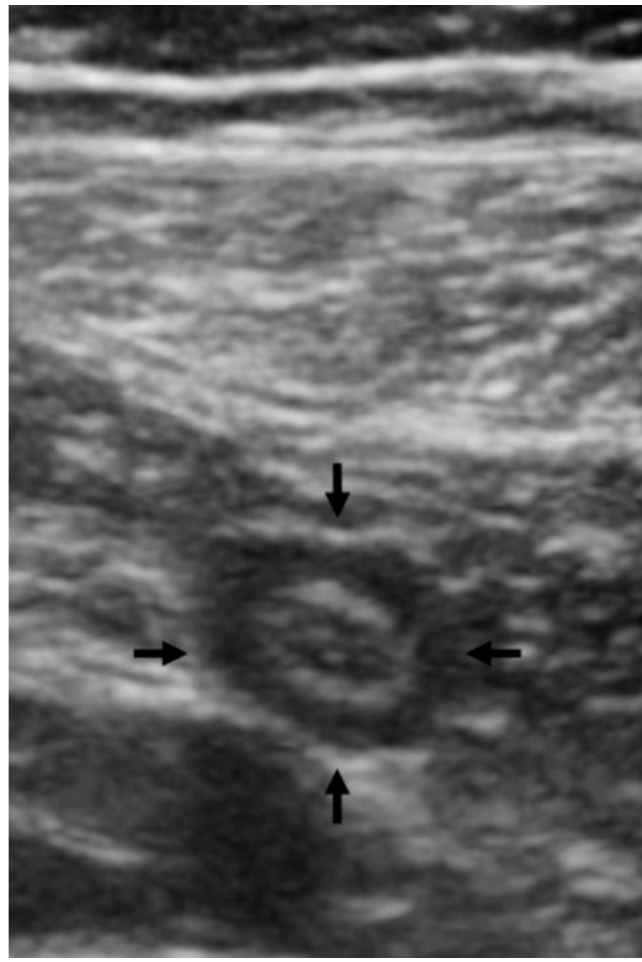
Figure. Cross-section of a tubular structure in the right lower